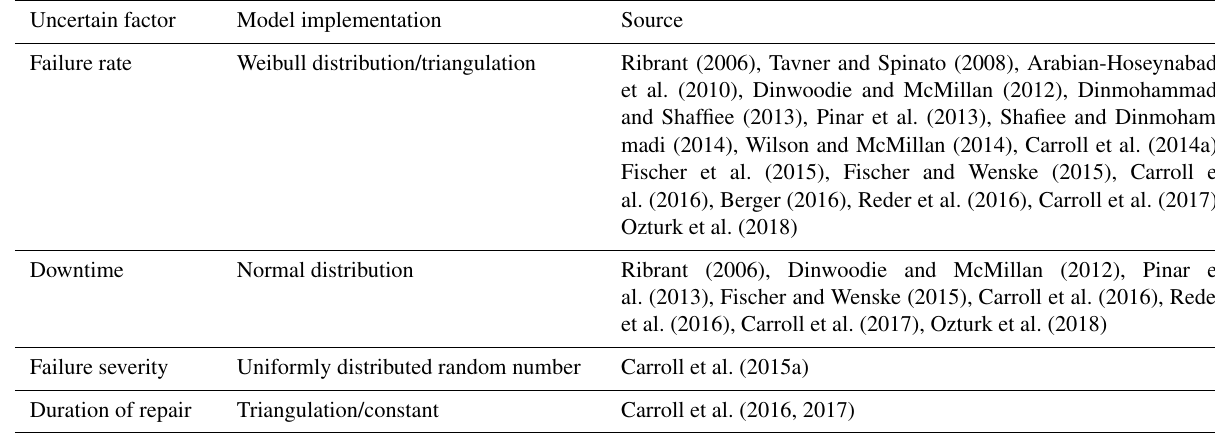
Table 2. Literature sources used for model